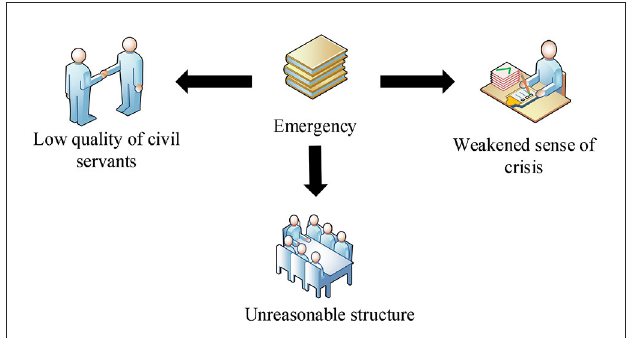
FIGURE4 Psychological intervention of civil servants in